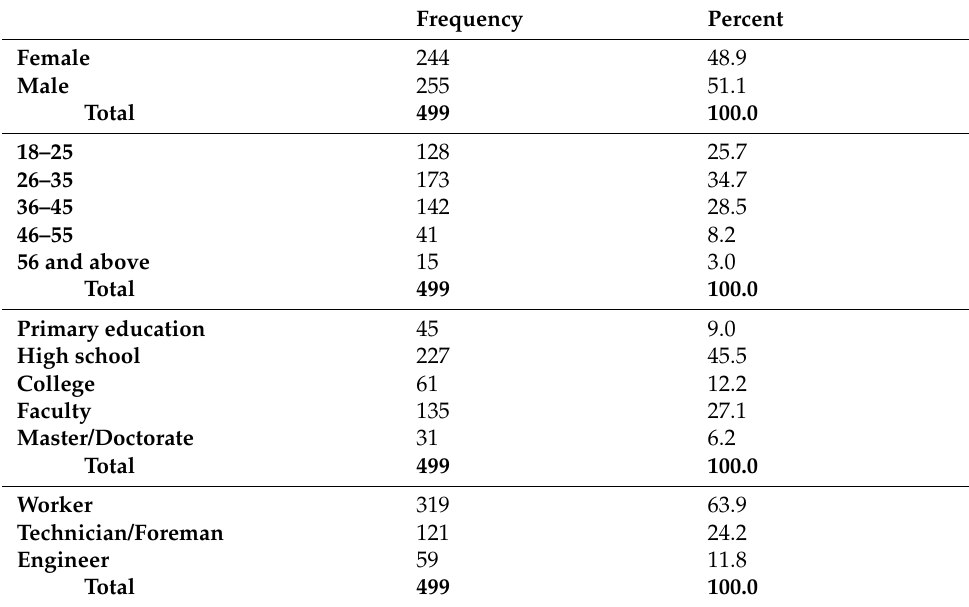
Table 1. Demographic Characteristics of Respondents.